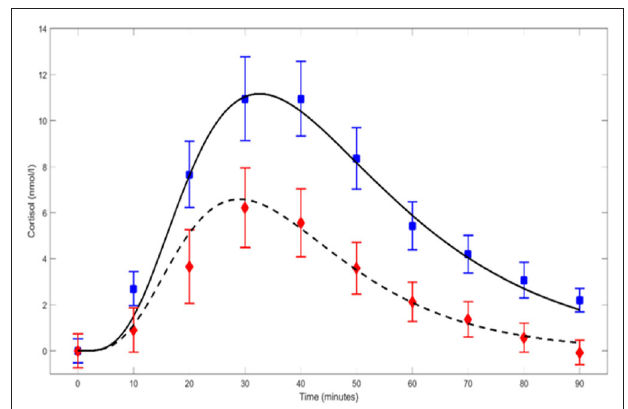
FIGURE 2 | Parameterized CoRe cortisol response curves for males (solid line) and females (dashed line) after prolonged exposure (20min) to, amongst others, the Trier Social Stress Test. The curves are based on data points (blue-male; red-female) published by Kirschbaum et al. (1992). Error bars represent ±